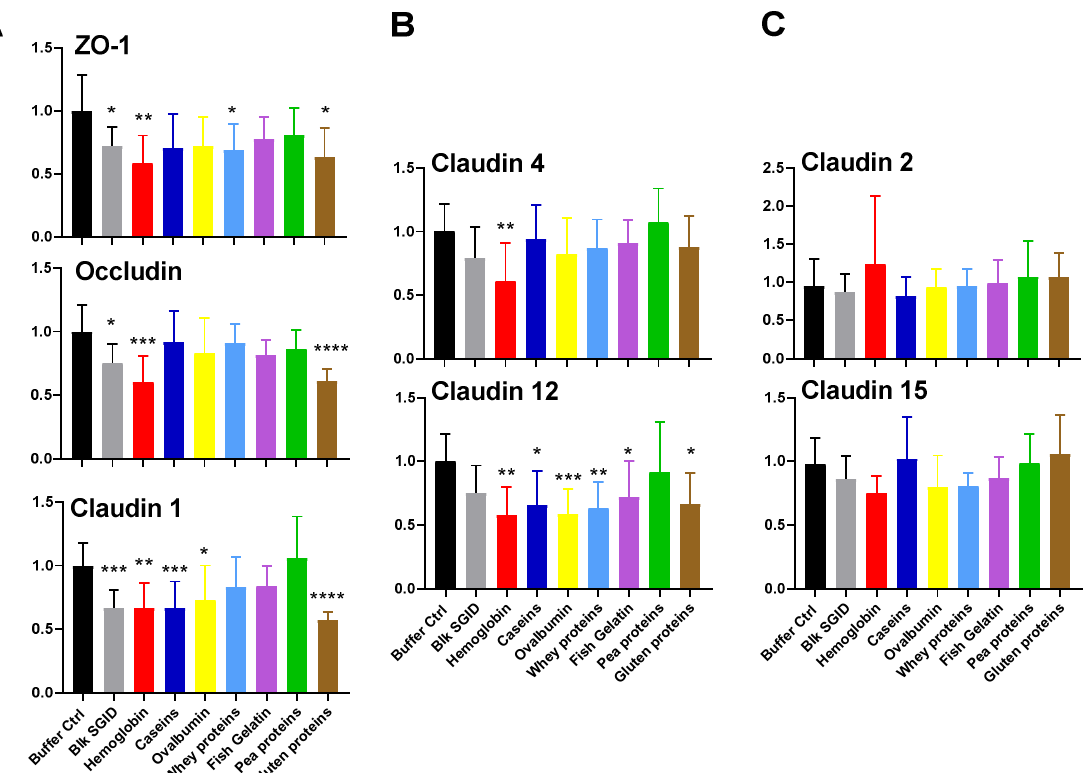
Figure 5. Digested proteins modulate TJ protein gene expression in vitro. ( A ) ZO-1, Occludin, and Claudin 1; ( B ) Claudin 4 and Claudin 12; ( C ) Claudin 2 and Claudin 15 mRNA relative expression levels normalized to HPRT1 in Caco-2/HT29-MTX cocultured cells incubated for 24 h with digested proteins (5 mg · mL − 1 ). The relative mRNA levels were expressed in the fold of the buffer control level value. For ZO-1, Claudin 1, Claudin 4, Claudin 2 and Claudin 15, the statistical analysis was performed using two–Way ANOVA analysis with Dunnett’s multiple comparison post-hoc test. For Occludin and Claudin 12, Kruskal–Wallis analysis was performed, followed by Dunn’s multiple comparison post-hoc test to compare digested protein samples to the Buffer Ctrl group (* p < 0.05; ** p < 0.01; *** p < 0.001; **** p < 0.0001) .